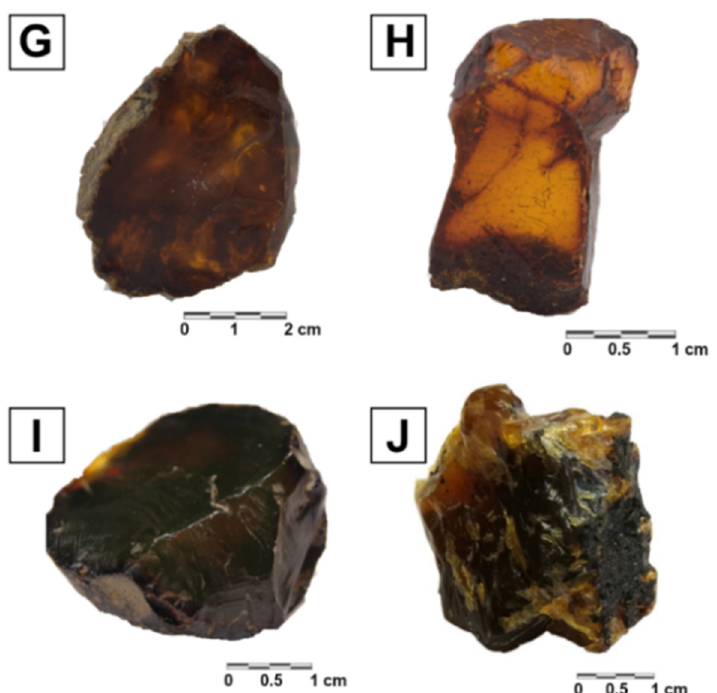
Figure 1. Macrophotos of fossil resins: ( A )—Khatanga, Russia; ( B )—Alem Ketema, Ethiopia; ( C )—Hukawng valley, Myanmar; ( D )—Sakhalin, Russia; ( E )—Sumatra (Palembang Province), Indonesia; ( F )—Sumatra (Jambi Province), Indonesia; ( G )—Chiapas, Mexico; ( H )—Santiago de los Caballeros, Dominican Republic; ( I )—El Valle, Dominican Republic; ( J )—Sarawak, Borneo, Malaysia .